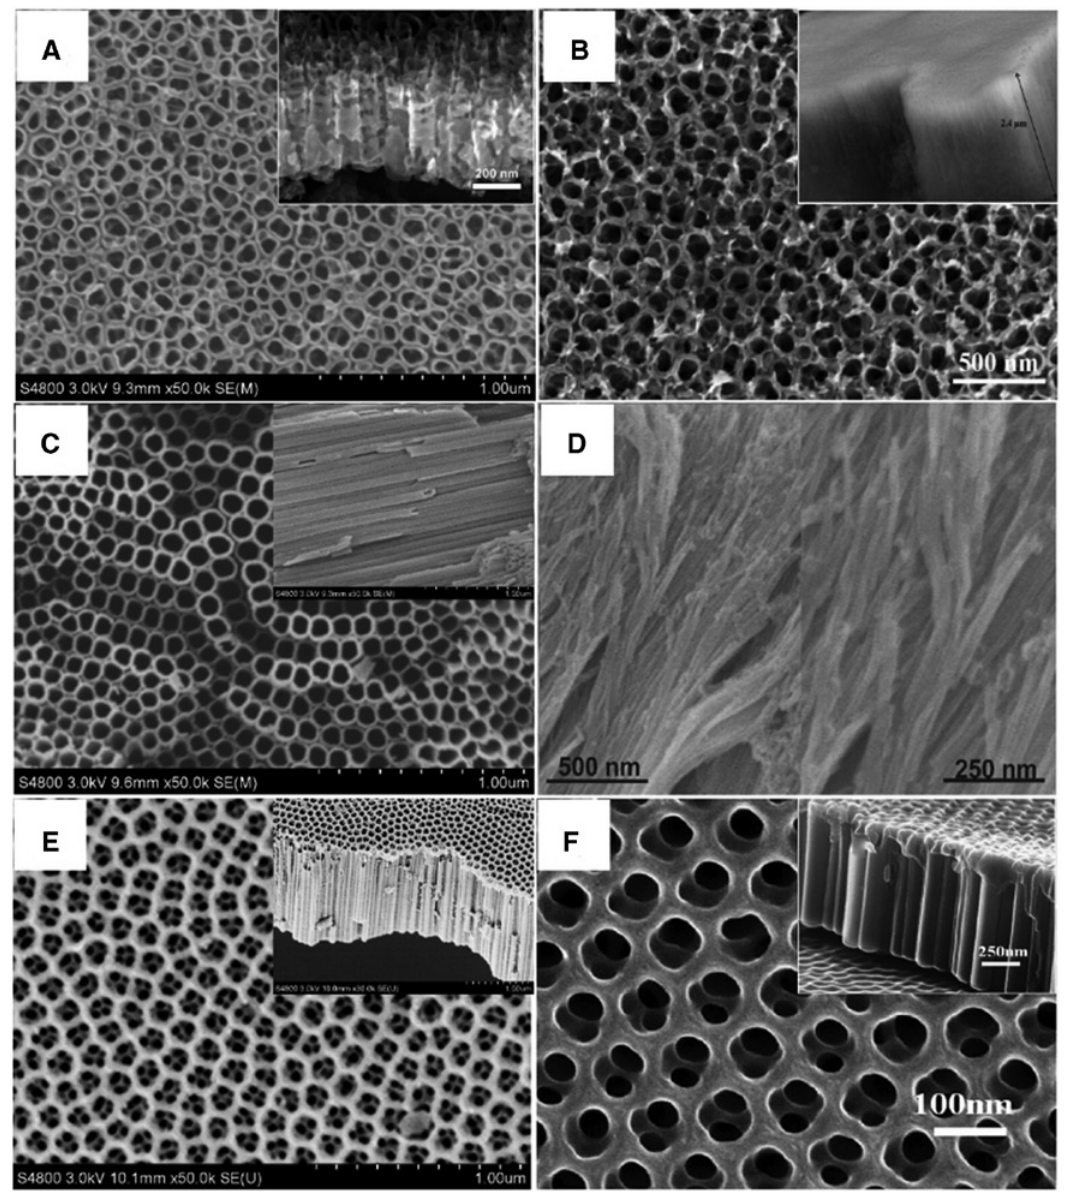
SO /NaF electrolyte (B), third generation in ethylene 2 4